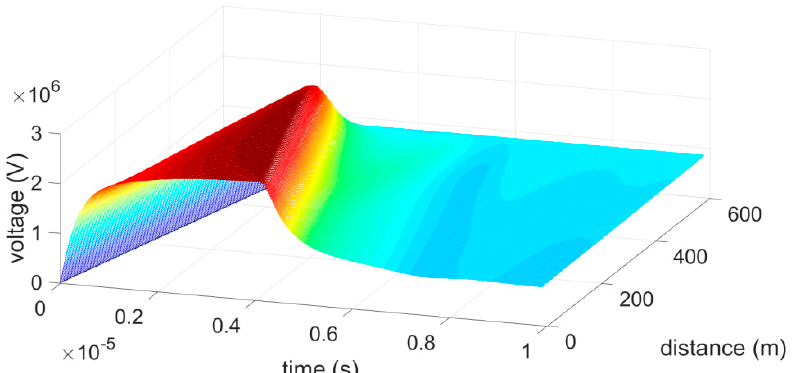
Figure 14. Computed transient voltage profile along phase A with surge arresters connected at the receiving node (example 3.3). The voltage magnitude significantly decreased along the transmission line compared to the transient profile presented in Figure 13.